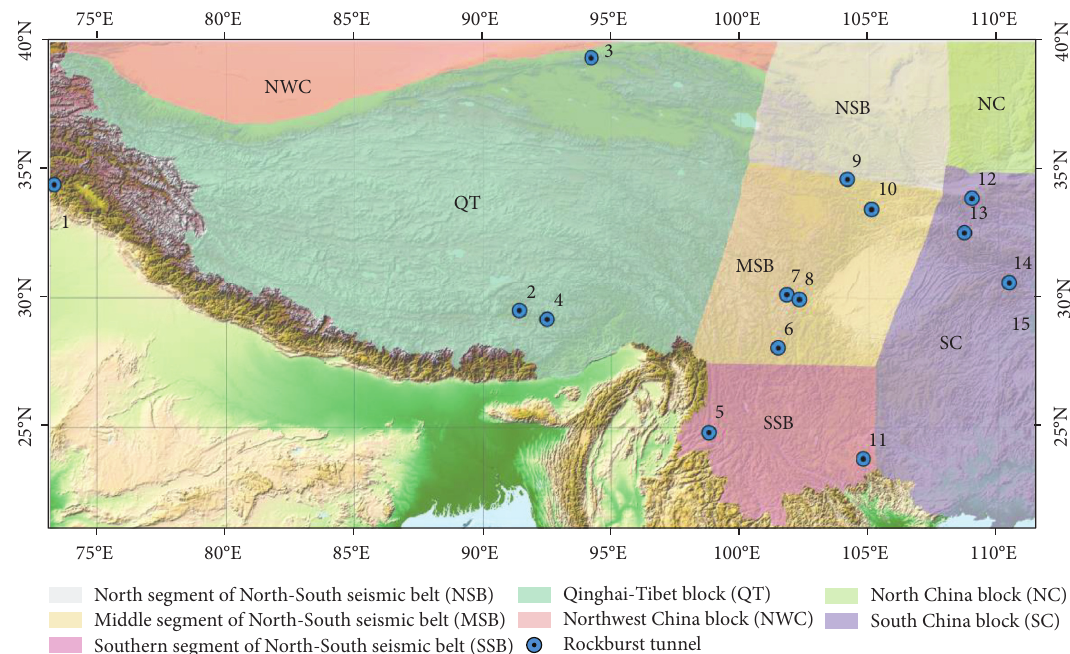
Figure 1: The range of Qinghai-Tibet Plateau and its adjacent region (adapted from [47,